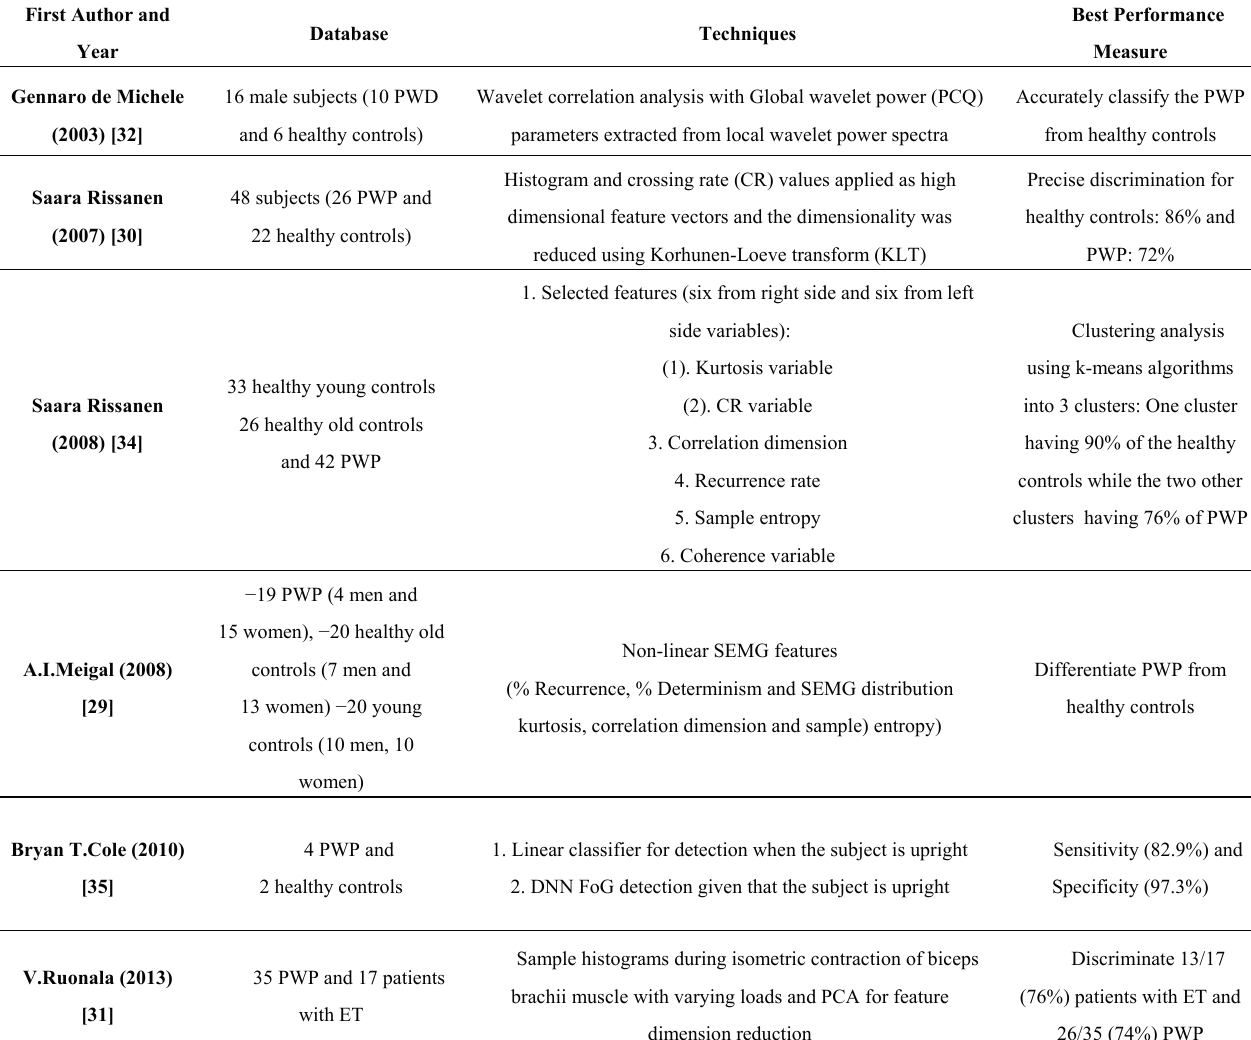
Table 1. Summary of previous works conducted using EMG